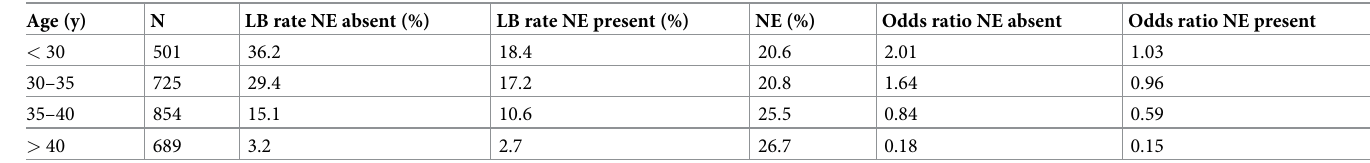
Table 4. Association between age, live birth, and nucleation error occurrence. Odds ratios are calculated on a univariate basis. Age (y) N LB rate NE absent (%) LB rate NE present (%) NE (%) Odds ratio NE absent Odds ratio NE present <